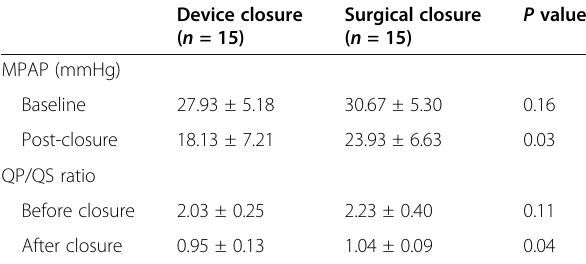
Table 5 PAP and shunt fraction (QP/QS) in both groups Device closure Surgical closure ( n = 15) ( n = 15)